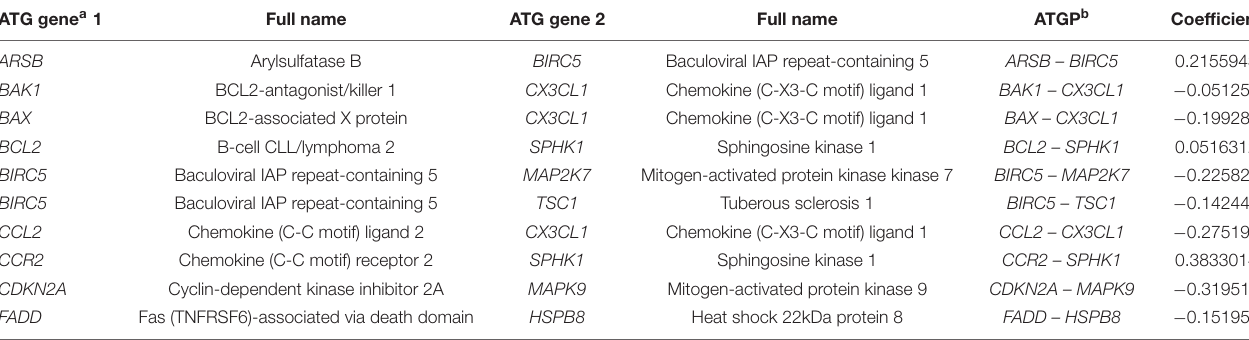
TABLE 2 | The autophagy-related (ATG) genes used to construct the autophagy-related gene pair index (ATGPI). ATG gene a